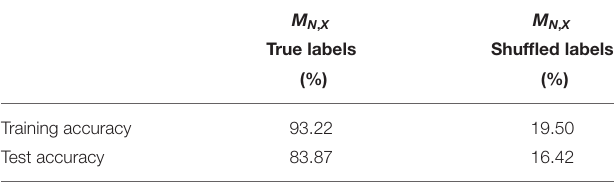
) obtained for an adversarially trained network: the A exceeds that of M N , X . A